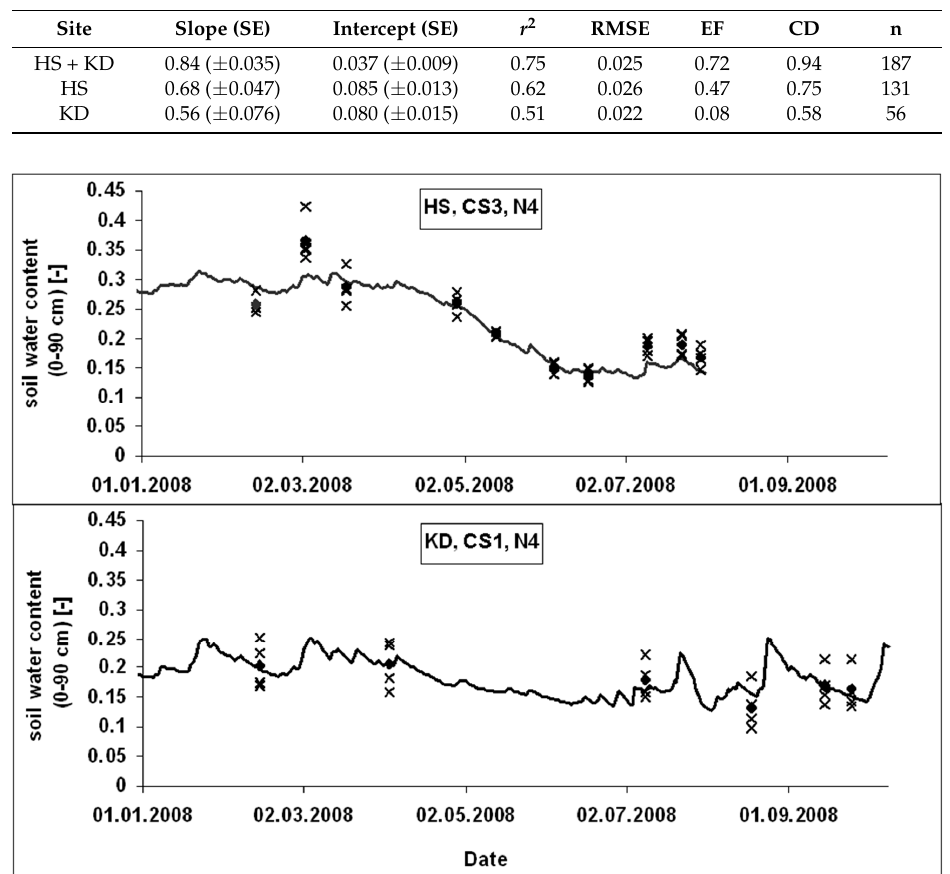
Figure 5. Measured and simulated soil water contents in the soil layer from 0–90 cm over time, based on examples for CS3 (silage maize–winter wheat for grain production, mustard as catch crop), N4 (360 kg N ha − 1 ) at Hohenschulen (HS), 2008 and CS1 (maize–maize), N4 (360 kg N ha − 1 ) at Karkendamm (KD), 2008. Lines assign simulation values, crosses assign single measured data points and closed symbols assign the average of the measurements.